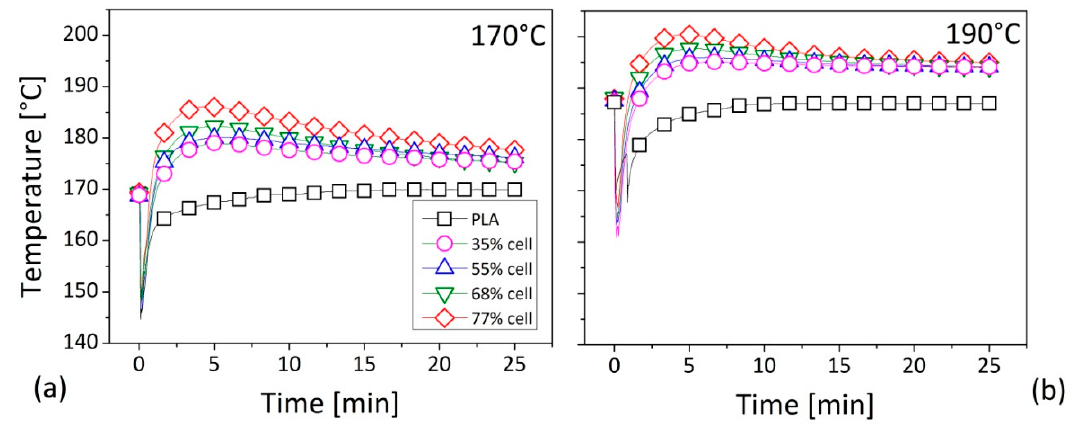
Figure 3. Temperature measurements as a function of the process duration during the mixing of the PLA–based composites: ( a ) at a temperature of 170 °C; ( b ) at a temperature of 190 °C. Legend in Figure 3b as in Figure 3a.